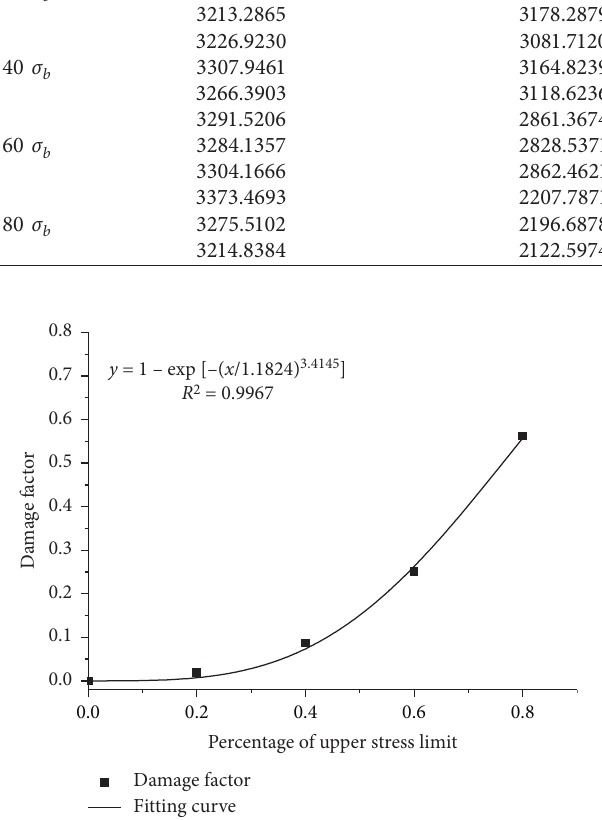
Figure 3: Variation law between damage factor and upper stress